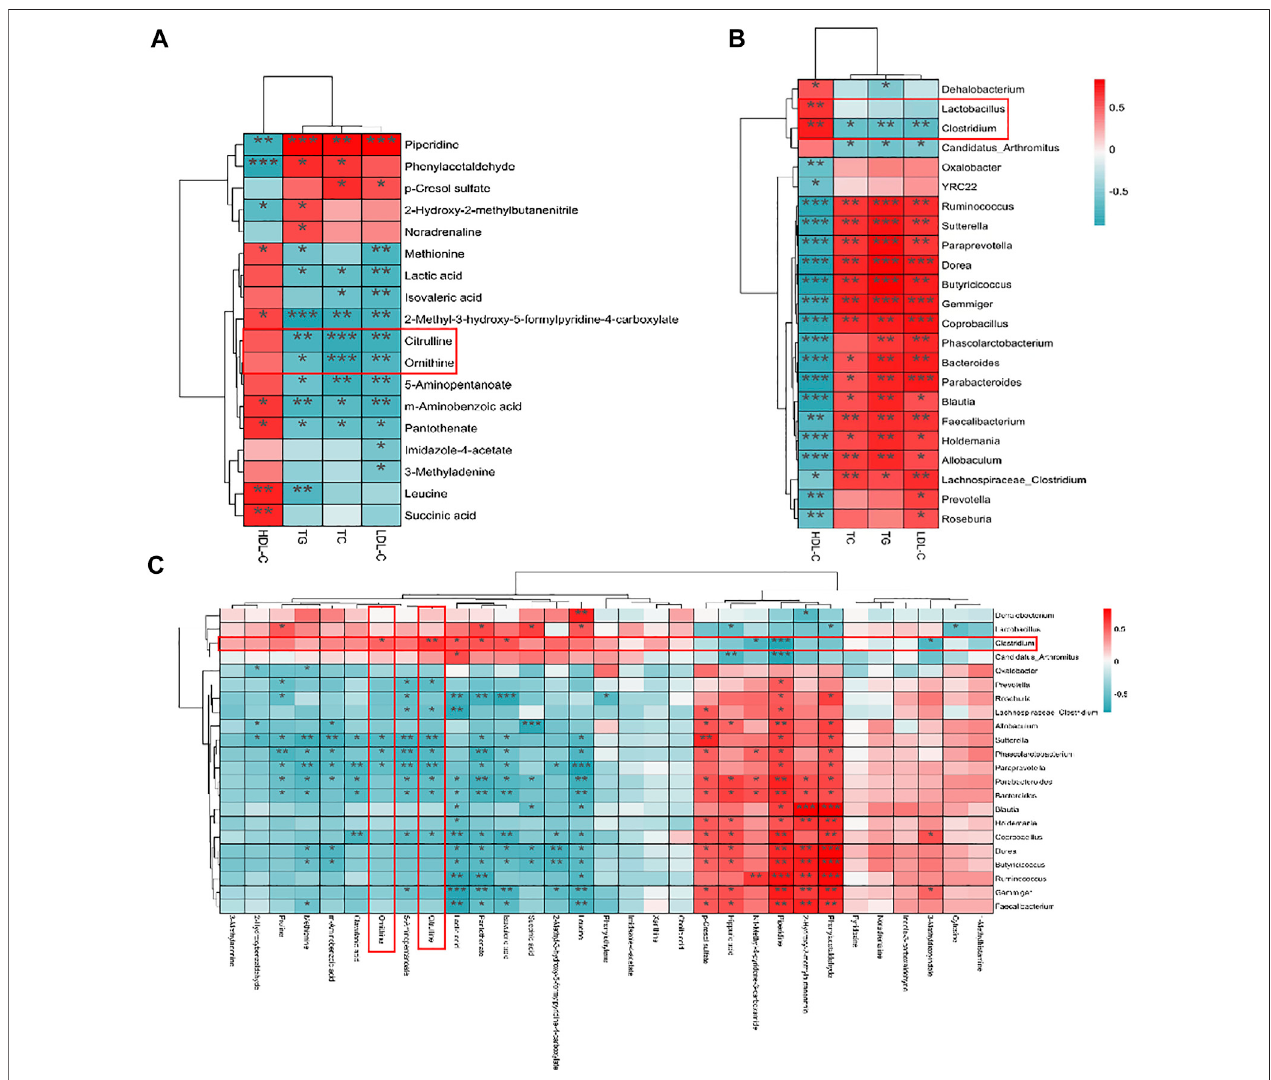
FIGURE 6 | Spearman ’ s correlation analysis results of omics data. (A) Heatmap of the correlations between plasma lipid parameters and fecal metabolites. (B) Heatmapofthe correlations between plasmalipid parametersand microbial genus abundances. (C) Heatmap ofthecorrelationsbetweenmicrobial genus abundances and fecal metabolites. * p < 0.05, ** p < 0.01, and *** p < 0.001 vs. Con